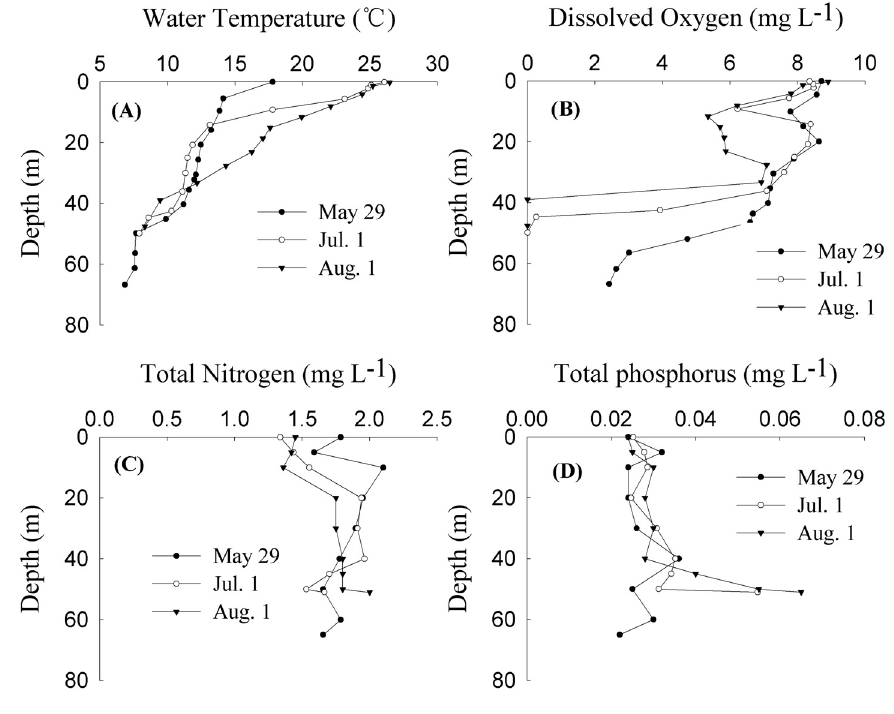
Figure 1. ( A – D ) Water temperature, dissolved oxygen, total nitrogen and total phosphorus profiles of the sampling dates at site A, in the Jinpen Drinking Water Reservoir,